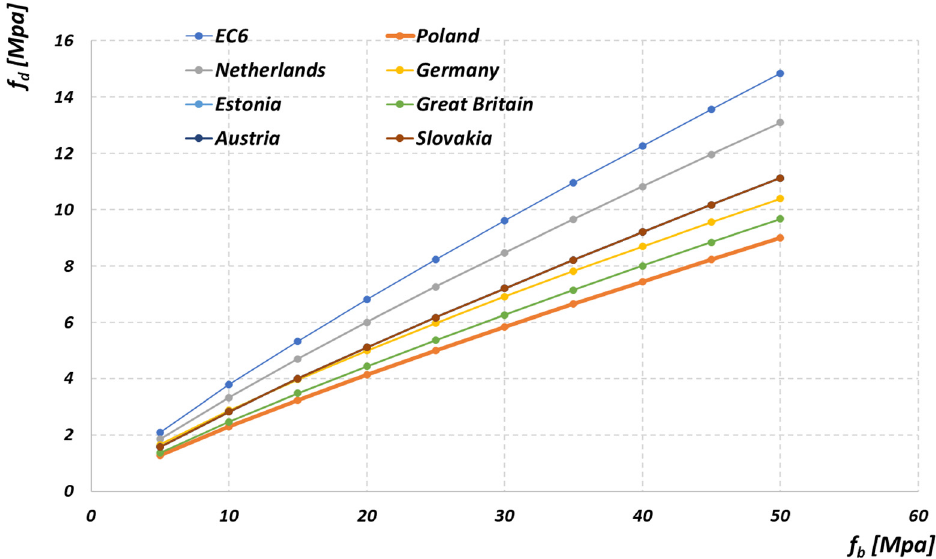
Figure 3. Dependence of the design strength of the masonry on the strength value of the masonry units for the masonry made of silicate units on thin layer mortar. units for the masonry made of silicate units on thin layer